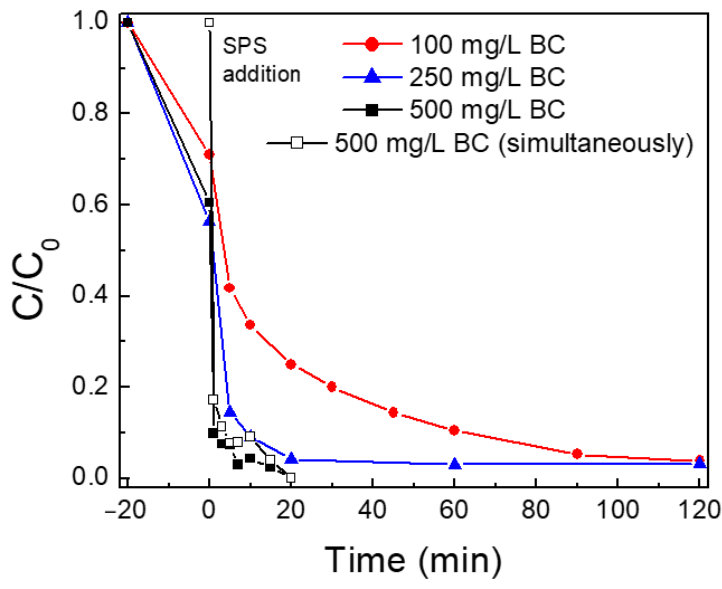
Figure 10. Effect of biochar (RHB 850) concentration on 500 µ g/L SMX degradation with 500 mg/L SPS in UPW and pH = 5.6.